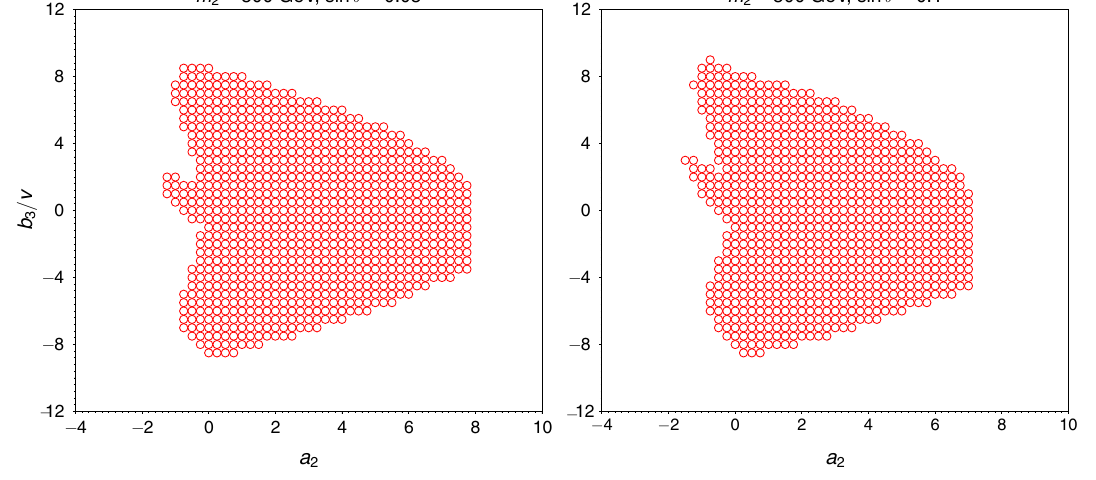
Fig. 11 Same as Fig. 10, but for m 2 = 500